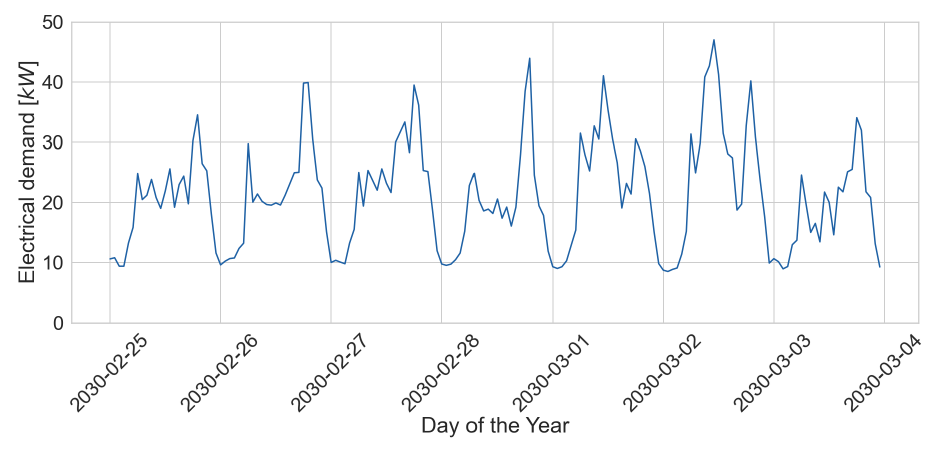
Figure 3. One-week example of the cumulative electric demand for the appliances generated with LPG tool.